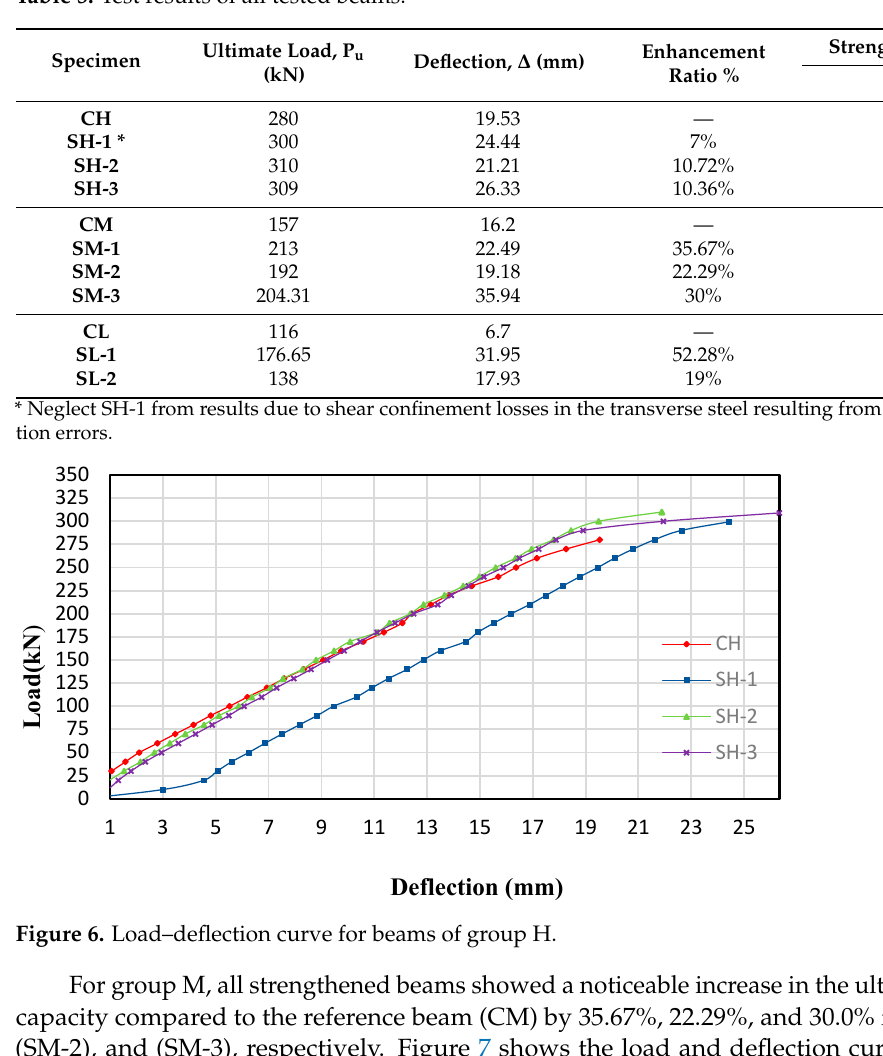
Table 5. Test results of all tested beams.